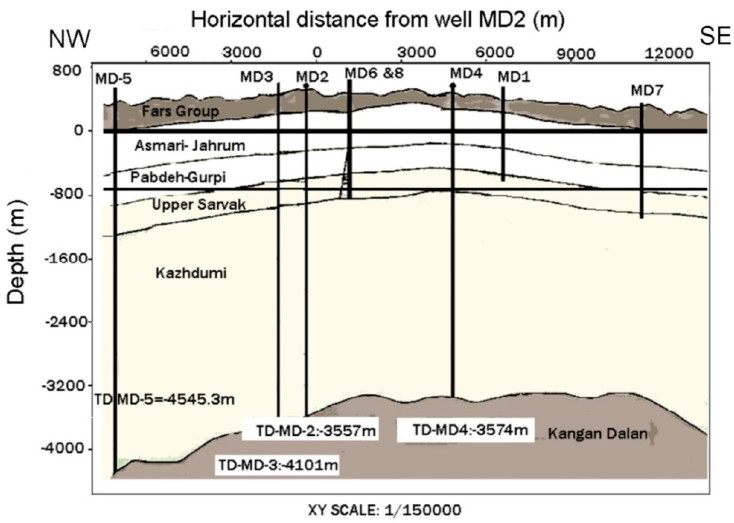
Figure 2. Geological cross section along the line X-X (See Figure 1). The X-X line is also parallel with the axis of the Kuh-e-Mond anticlinal structure. The location of wells especially wells MD-1 to MD-8 is presented here. Drilling of MD-8 which is the last appraisal well drilled in the field is benefited from the studies reported in this paper over the past decade. In addition, the cores and the image logs all belong to